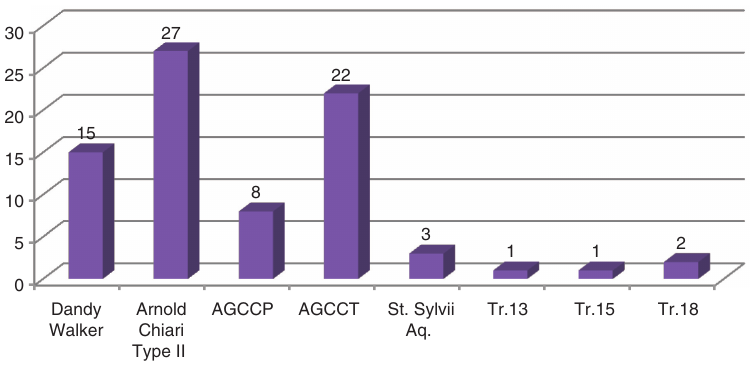
Figure 1 Syndromes in which hydrocephalus is present.